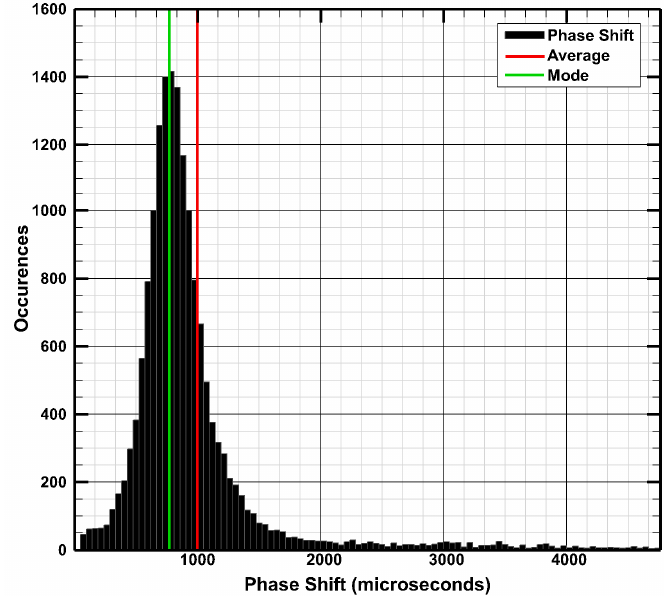
Figure 9. Time for an unsteady structure to traverse from Transducer 1 to Transducer 2, histogram.